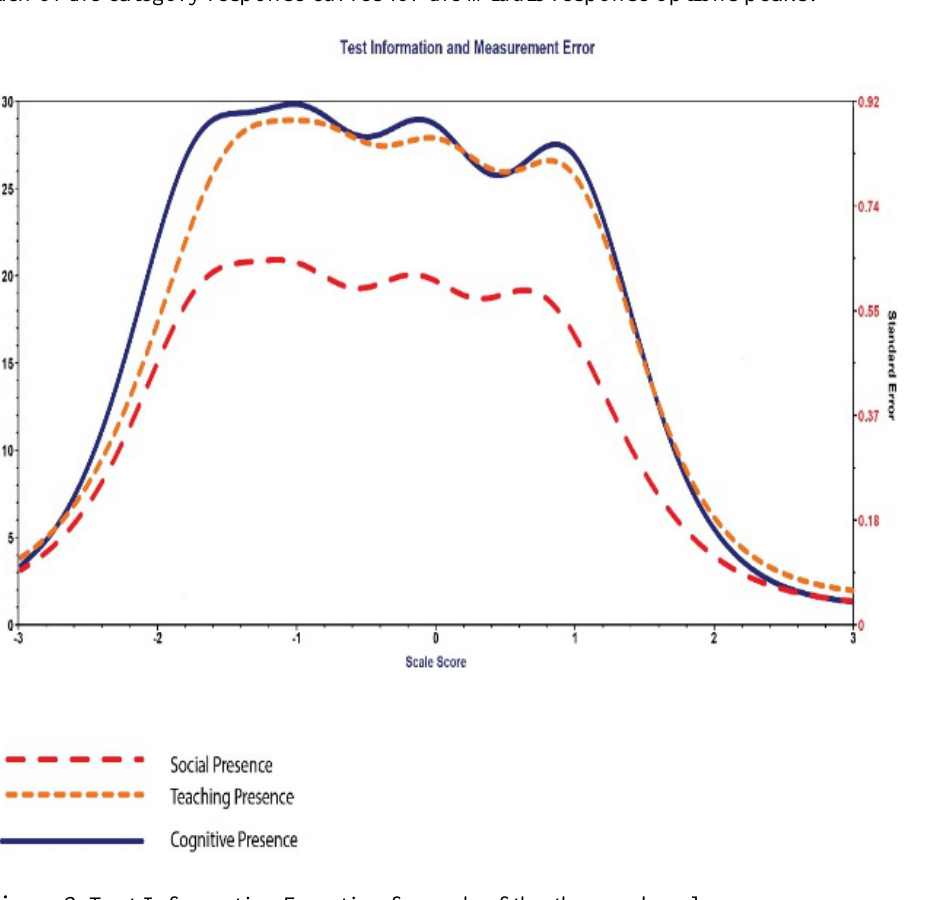
Figure 2 . Test Information Function for each of the three